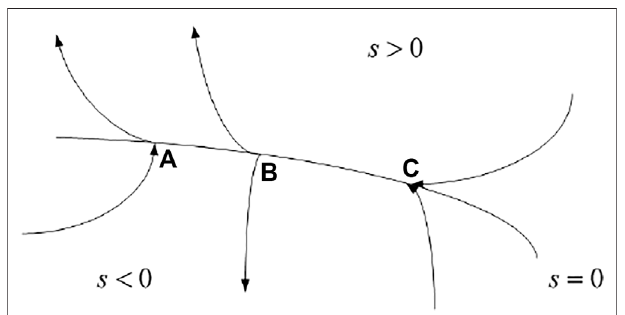
FIGURE 2 | Synovial hypersurface